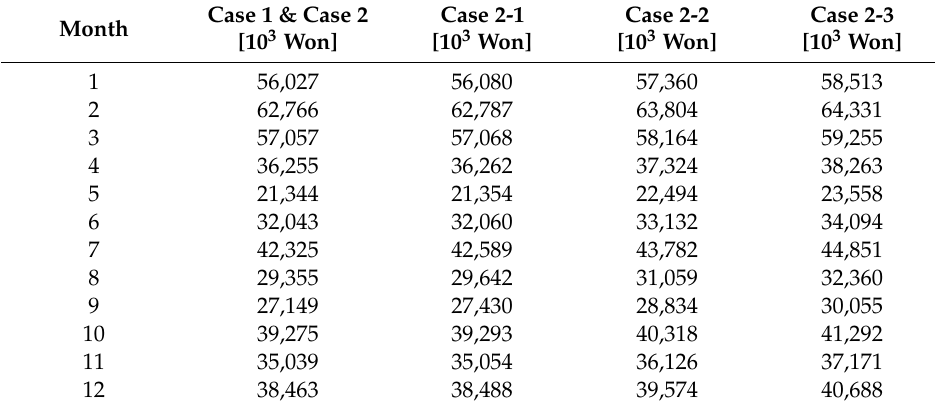
Table 7. Total net revenue